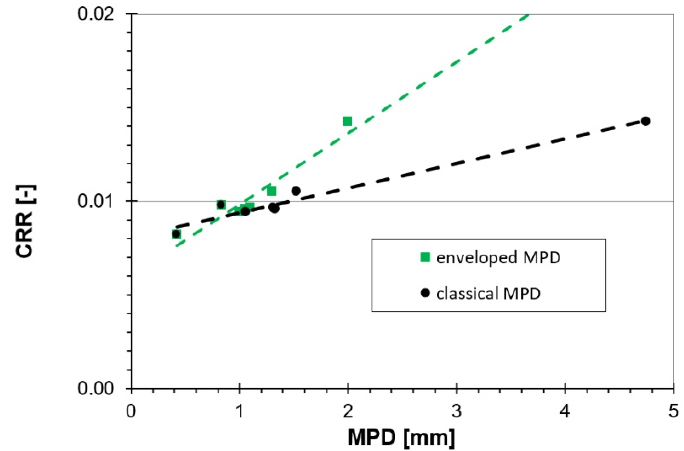
Figure 16. Comparison of relations between MPD (evaluated in the classical method and using enveloping correction) and Coefficient of Rolling Resistance.